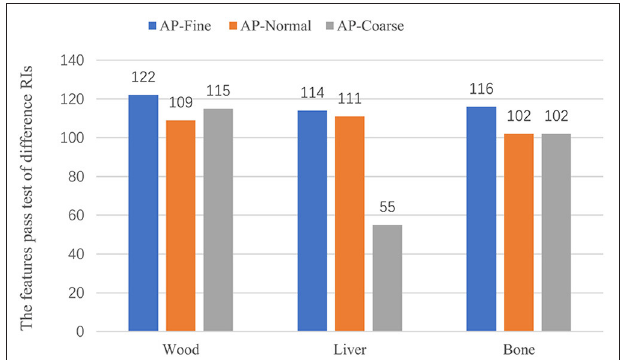
FIGURE 6 | Result of the RI tests for wood and tissue. The test included three AcPs (fine, normal, and coarse) with two RIs for each